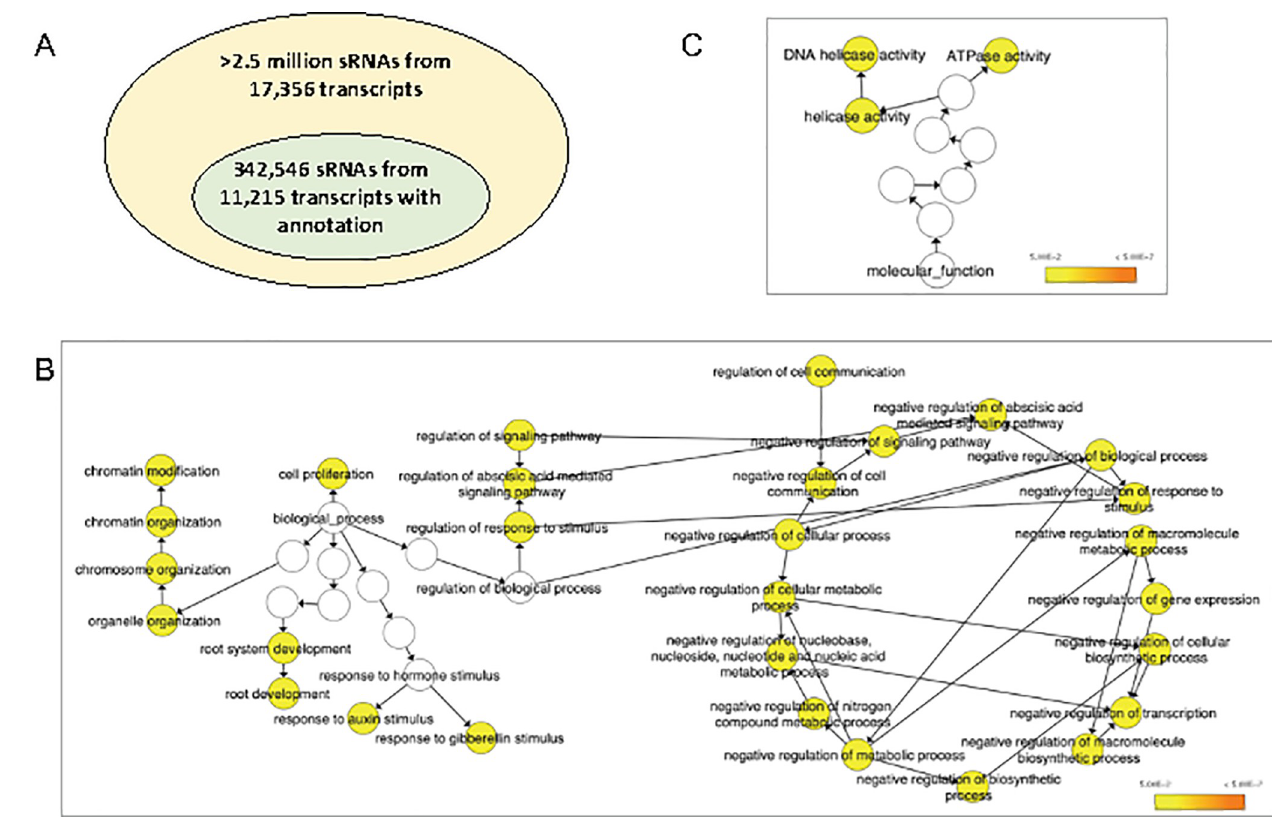
Fig 2. Summary of sRNAs (A) and gene networks of overrepresented sRNAs in bud tissues of sweet cherry scion 15 (Scion15) ‘Emperor Francis’ grafted on a ‘Gisela 6’ rootstock (RS15). The ontology file of GO_FULL in BiNGO and A . thaliana annotation were used as the references to identify overexpressed GO terms ( P < 0.05). Bubble color indicates the P -value. Overrepresented sRNAs in “Biological process” (B) and “Molecular function” (C). No overrepresented GO terms are present in “Cellular component”.